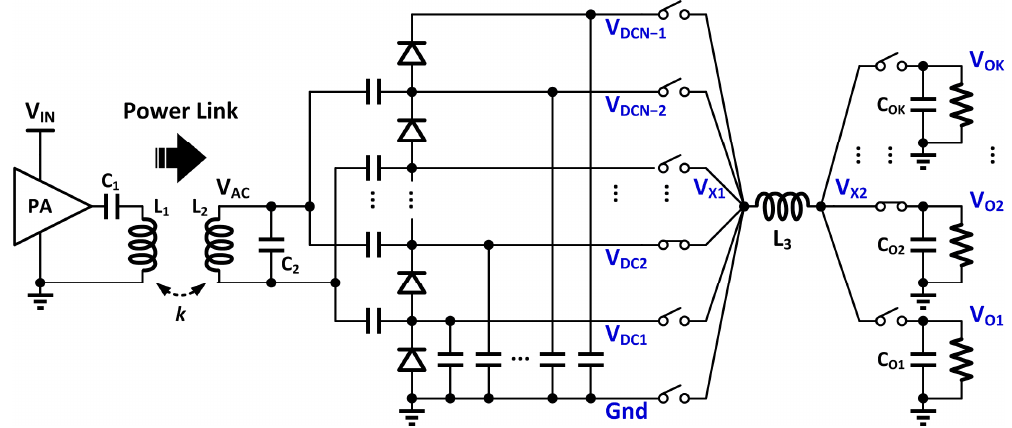
Figure 12. A WPT receiver with a Dickson-type multi-stage rectifier merged with a multi-level SIMO converter [27].